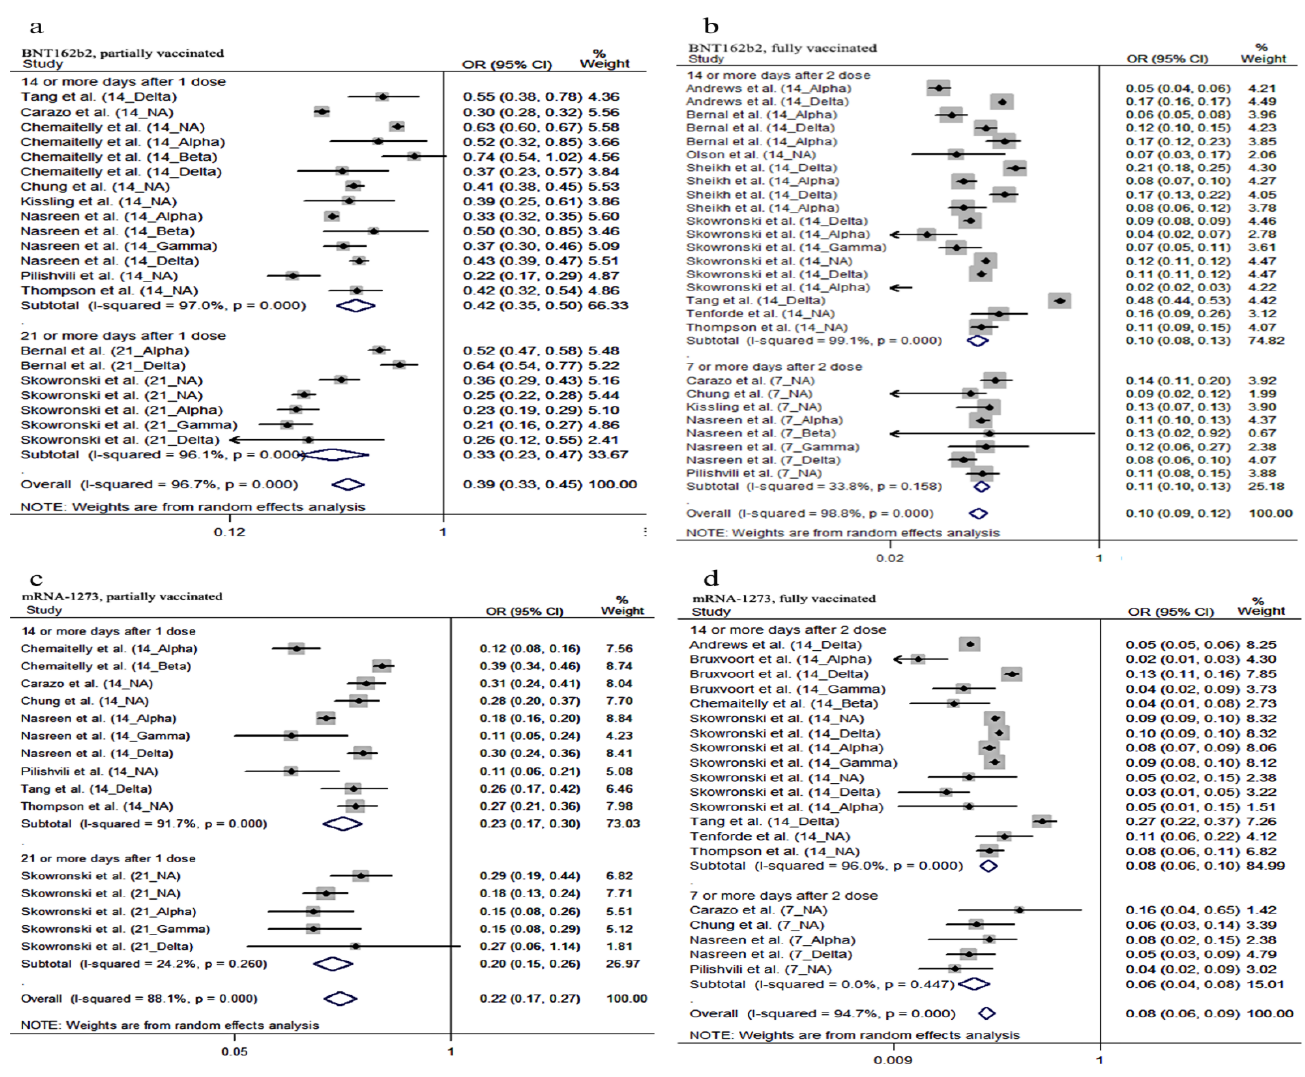
Figure 4. Forest plot odds ratio (OR) against COVID-19 by time ( a ): OR with 95% confidence intervals (CI) against COVID-19 infection of 14 or more days after being partially vaccinated (BNT162b2); ( b ): OR with 95% confidence intervals (CI) against COVID-19 infection of 14 or more days after being fully vaccinated (BNT162b2); ( c ): OR with its 95% confidence intervals (CI) against COVID-19 infection of 14 or more days after being partially vaccinated (mRNA-1273); ( d ): OR with its 95% confidence intervals (CI) against COVID-19 infection of 14 or more days after being fully vaccinated